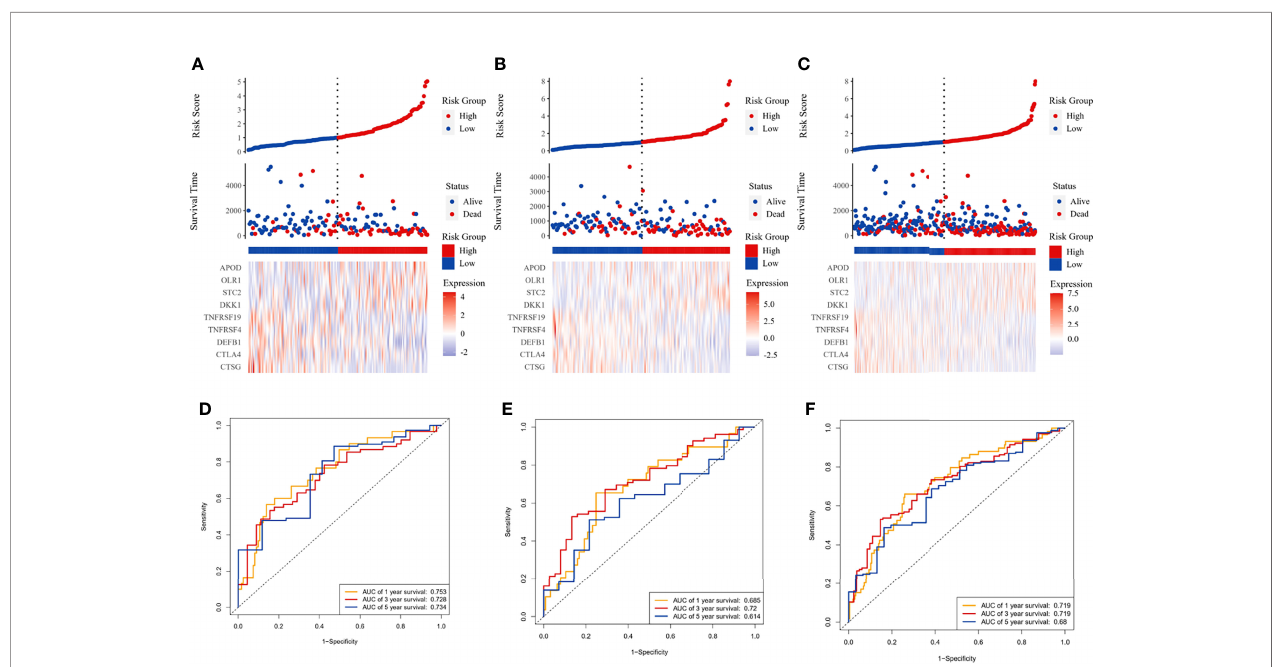
FIGURE 1 | Immune-related prognostic model construction in the TCGA cohort. The prognostic signi fi cance of risk scores was evaluated using the training set (A, D) , the testing set (B, E) , and the whole TCGA set (C, F) , respectively. (A – C) The fi rst panel from top represents the risk score distribution of the samples. The intersecting point represents the median of risk scores. The second panel from the top was the distribution of OS status and risk scores. The bottom panel was the heatmap of the mRNA expression of the nine immune-related DEGs. (D – F) The ROC curve for predicting 1-, 3-, and 5-year overall survival